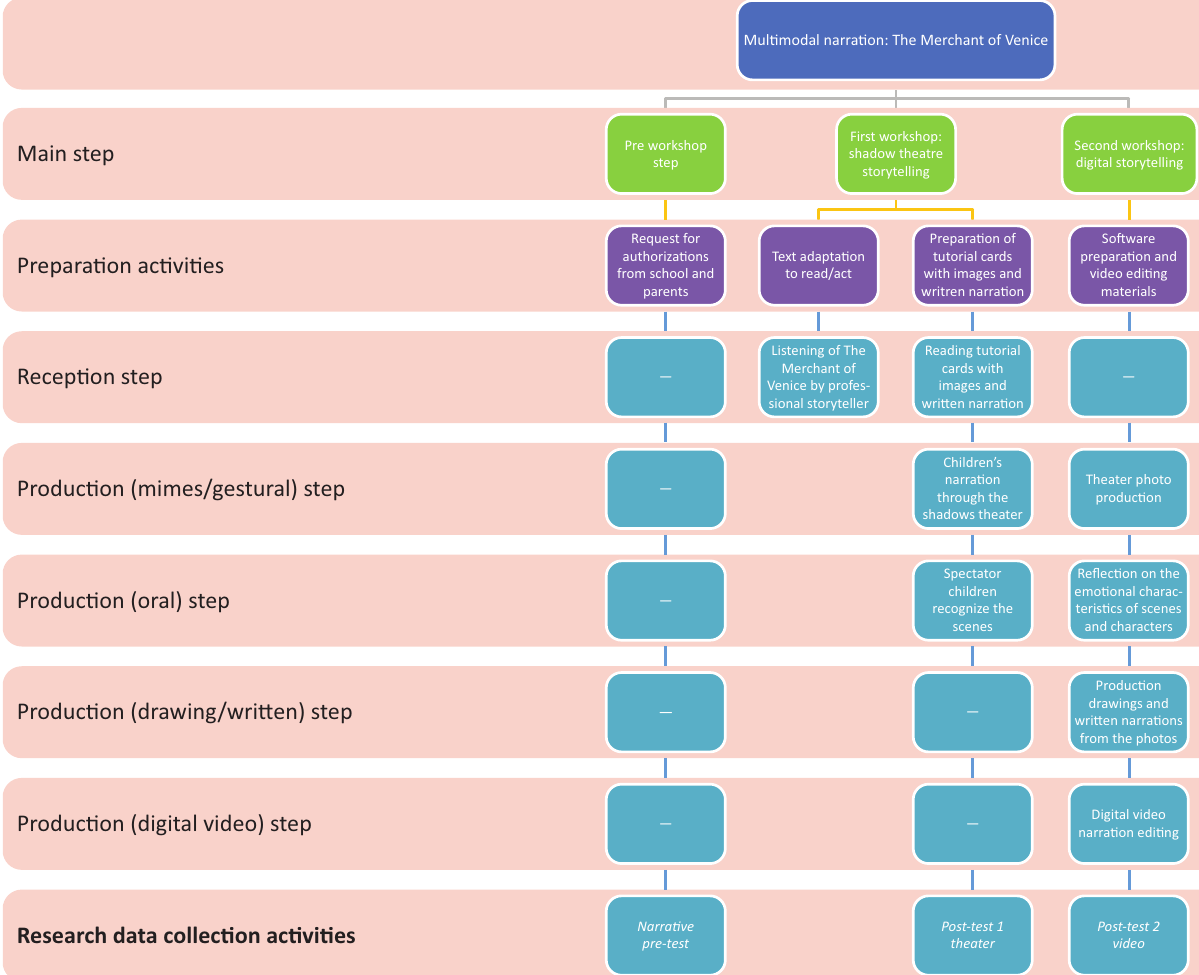
Figure 1. The phases of the exploratory study and the educational narrative